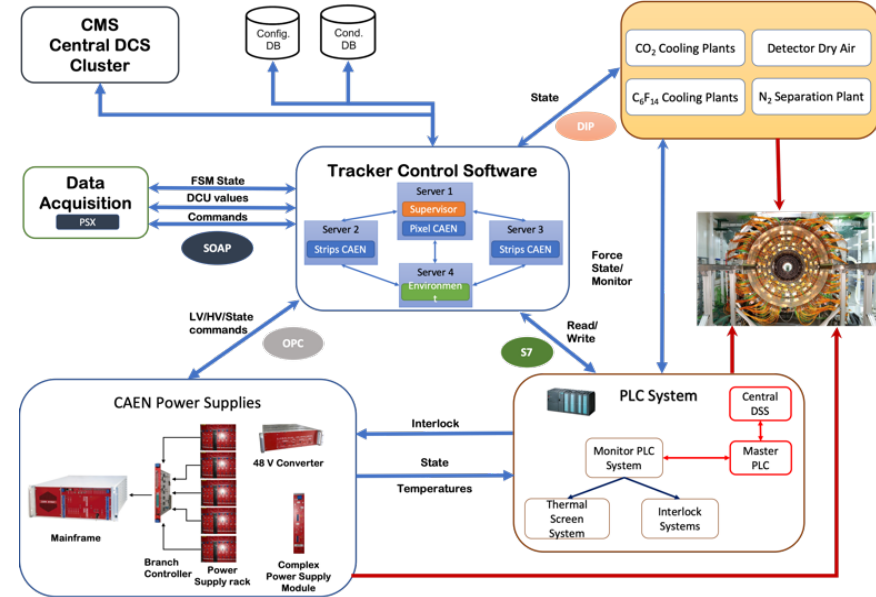
Fig. 1. Overview of the Tracker Control